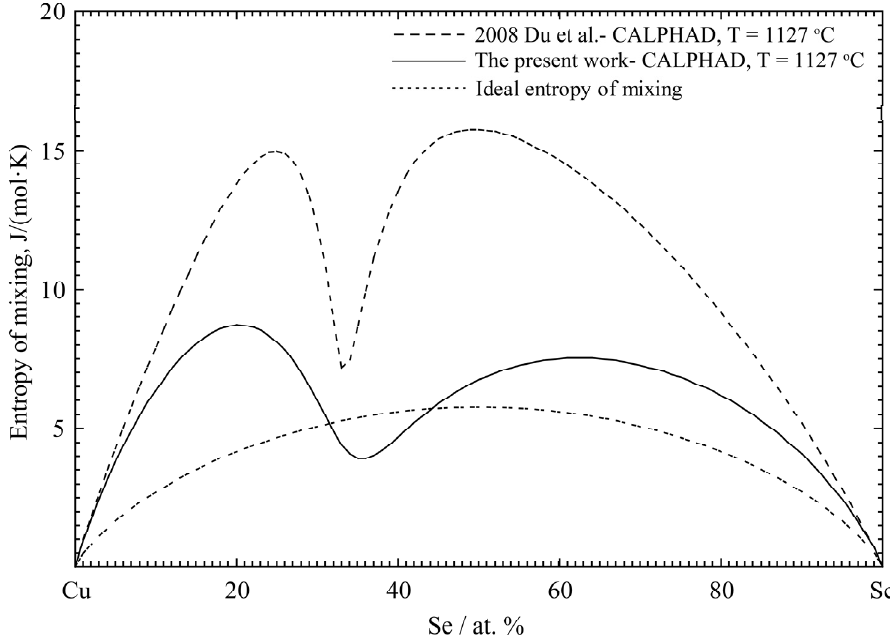
Figure 10. The calculated enthalpy of mixing for the liquid phase at 1127 °C in the Cu-Se system compared with previously optimized results by Du et al. [100].